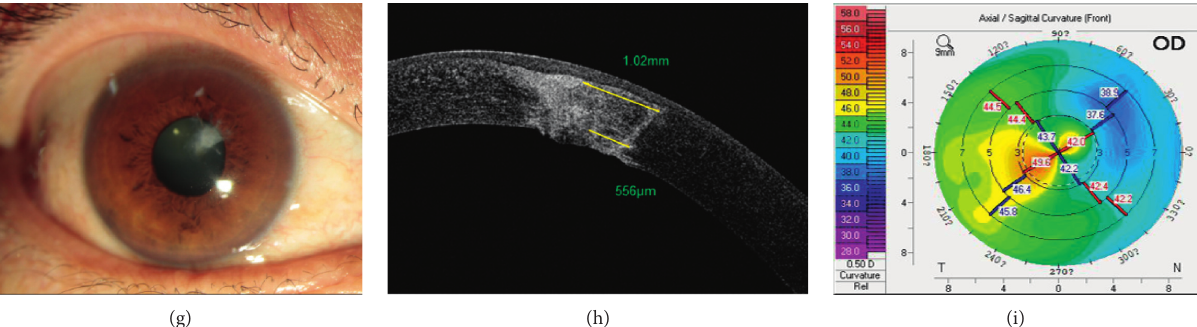
Figure 3: Penetrating corneal patching using an irregular wedge-shaped graft for cornea laceration combined with tissue defects. (a) Radial ruffles form in the central cornea because of tight stitching, with the UCVA being 1.0 logMAR. (b) AS-OCT indicates distortion of the corneal contour. (c) Morphology of tissue defects after suture removal. (d) A photograph at 1week after surgery. (e–f) Examination at 8 months after surgery. (e) AS-OCTshows that the width of the anterior surface of the patch is 1.04mm, and that of the posterior surface is 583 μ m. Scar forms in the injured cornea at the temporal side of the patch. (f) The graft opacity is slightly increased, and the UCVA is 0.30 logMAR. (g–i) Examination at 24 months after surgery. (g) The graft opacity is slightly decreased, with the UCVA being 0.15 logMAR. (h) AS-OCT shows the profile of the corneal patch. (i) The curvature of the front cornea is 43.0/45.9.